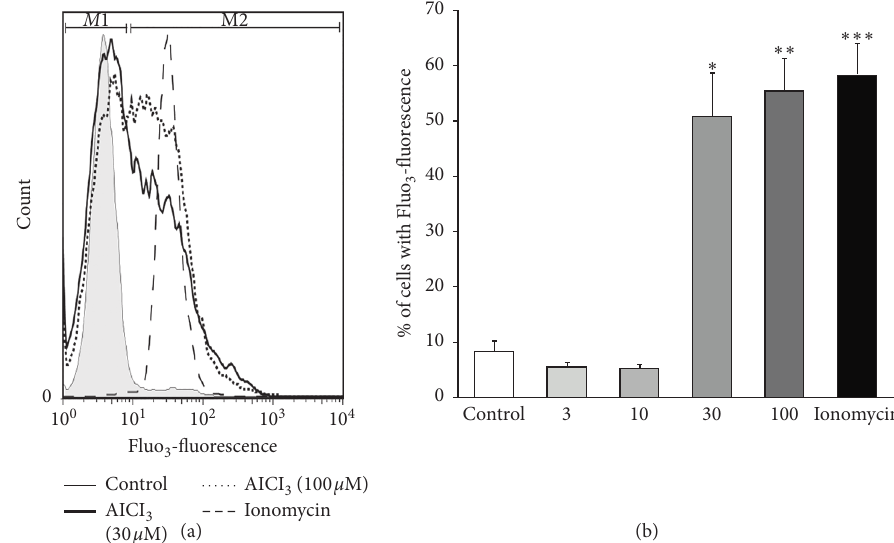
Figure 5: The effects of various concentrations of AlCl 2+ levels in the erythrocytes. (a) Histogram of Fluo 3 on intracellular Ca 3 -fluorescence of the erythrocytes following exposure for 24hours to Ringer solution without (control; grey area) and with the presence of 30 μ M (black line) and 100 μ M of AlCl 3 μ M (dotted line) and 1 µ M of ionomycin (positive control; dashed line). (b) Arithmetic means ± SD of the percentage of erythrocyte with enhanced Fluo 3 -fluorescence following treatment with various concentrations of AlCl 3 and ionomycin (1 µ M), in Ringer solution for 24hours. ∗ , ∗∗ , and ∗∗∗ P < 0.001 significant difference compared to control groups.